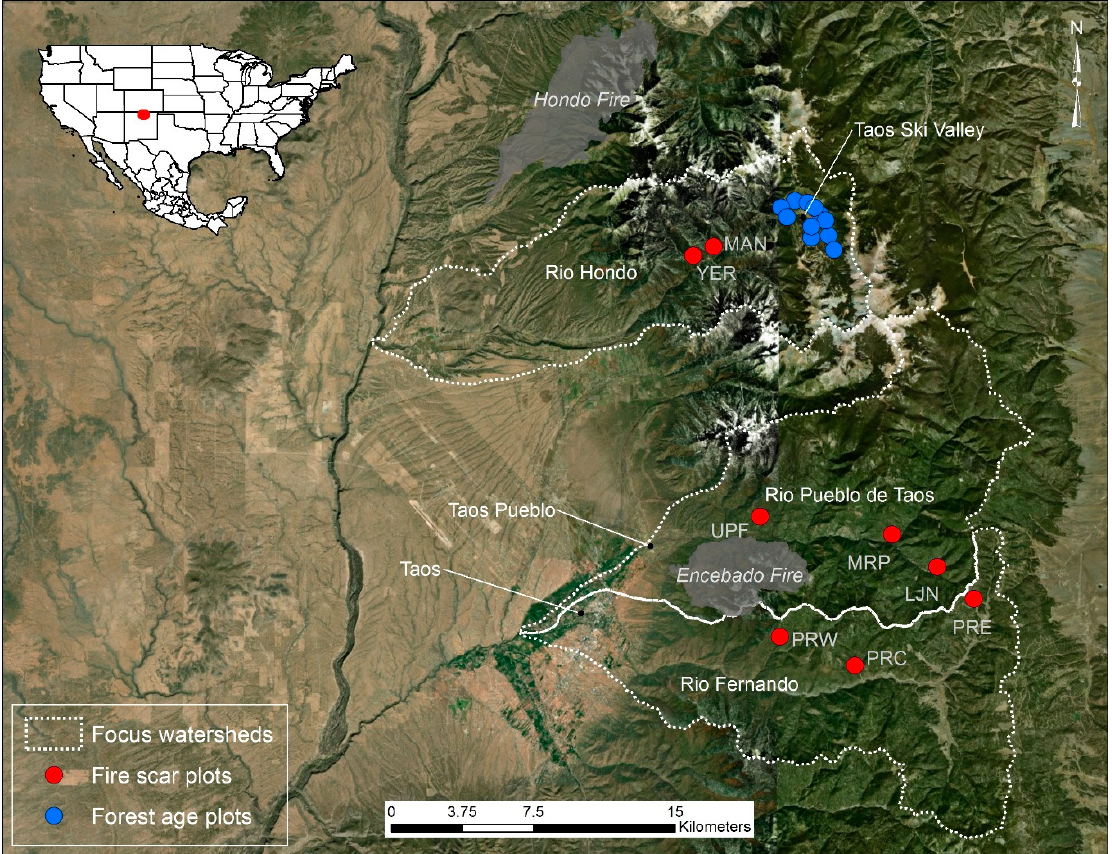
Figure 2. A map of the study area, the focal watersheds, the fire scar and forest-age plots, and the recent large wildfires in the Taos Valley Watersheds in northern New Mexico. The 2018 Ute Park fire was 25 km east of the study area. See Table 1 for the plot names.